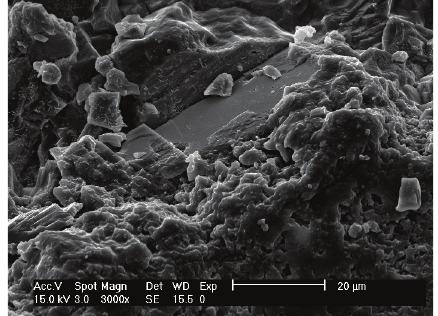
Figure 7: Interface between RAP and asphalt